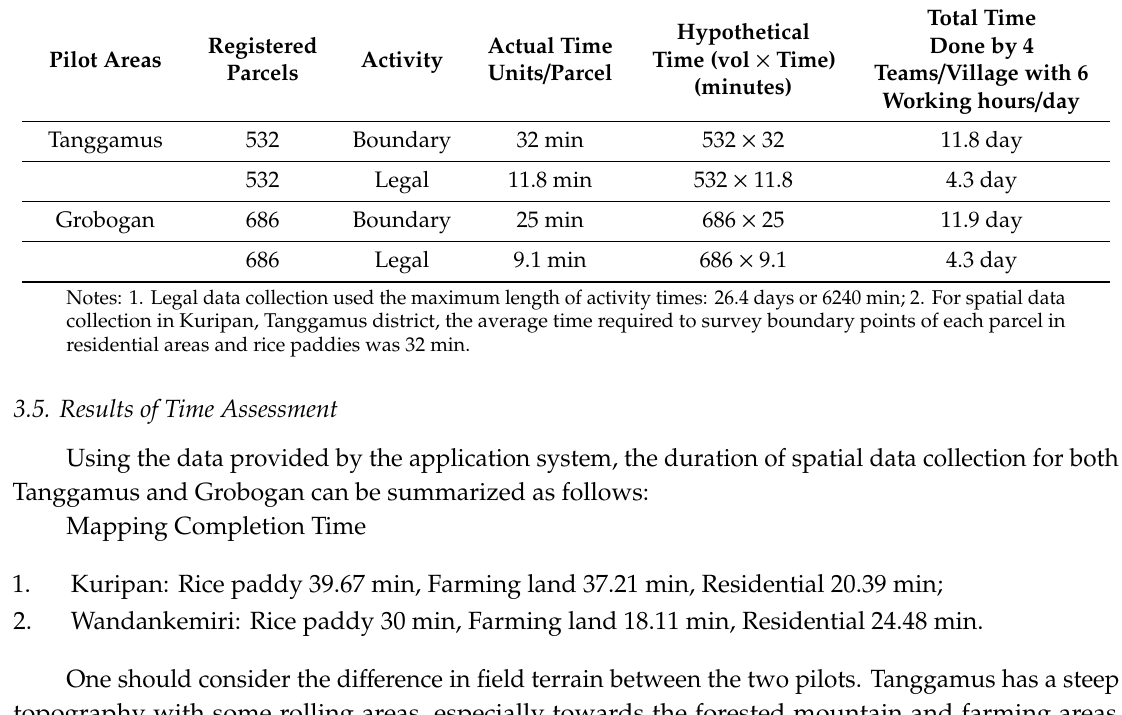
Table 6. The actual and hypothetical time required in PaLaR